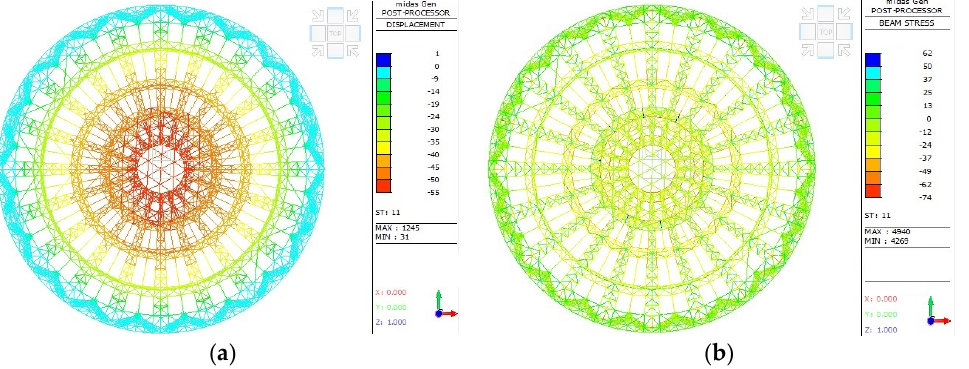
Figure 18. Displacement and stress cloud diagram of steel structure. ( a ) Displacement cloud diagram of steel structure after tension, ( b ) stress cloud diagram of steel structure after tension.